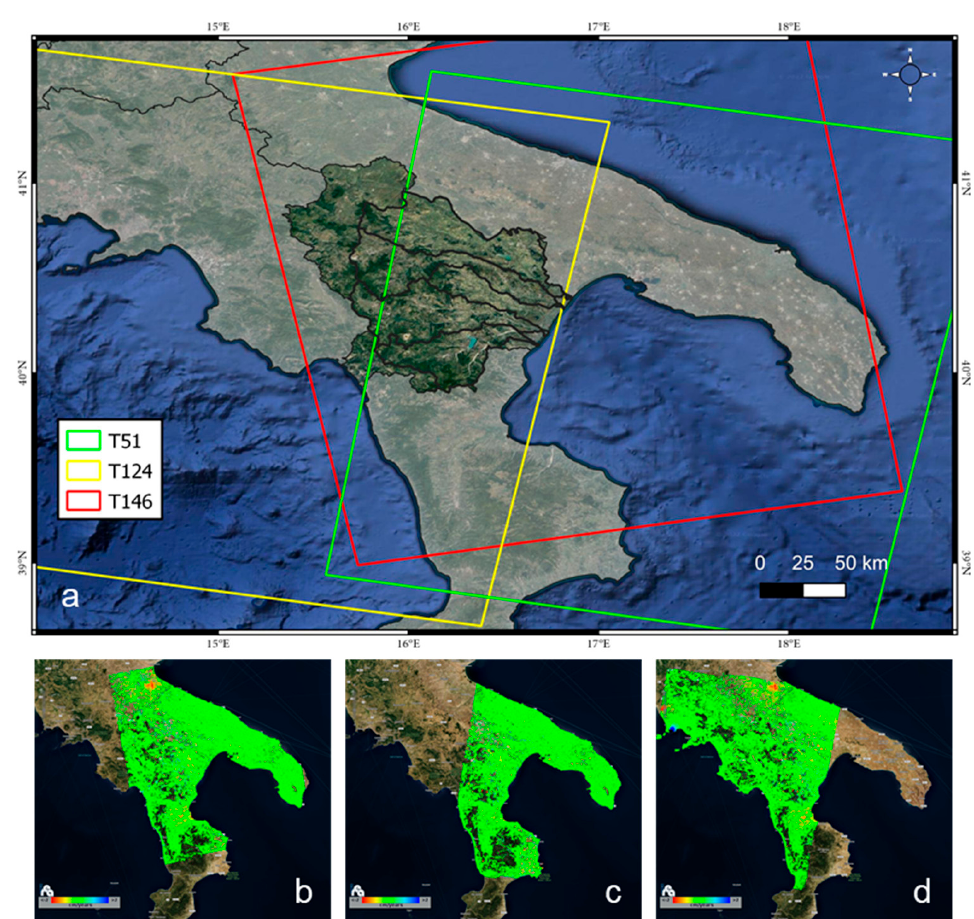
Figure 4. ( a ) Sentinel-1 tracks used in this work. Results of the P-SBAS analysis for the ( b ) T146, ascending, and ( c ) T51 and ( d ) T124, descending orbits. Background from Google Earth.